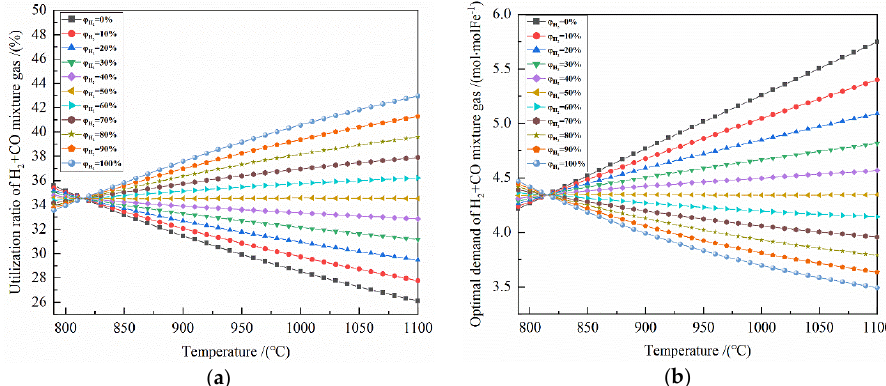
Figure 6. The effect of reduction temperature on the reduction of Fe 2 O 3 at 790–1100 ° С with varied H 2 concentrations: ( a ) utilization rate of H 2 + CO mixture gas; ( b ) optimal demand of H 2 + CO mixture gas.